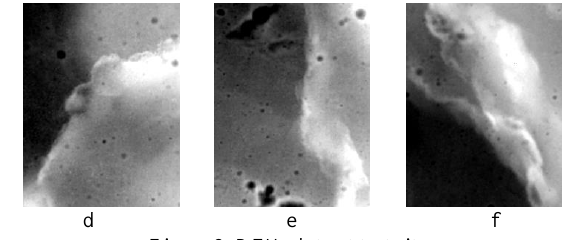
Figure 6. Ridge detection results at test sites